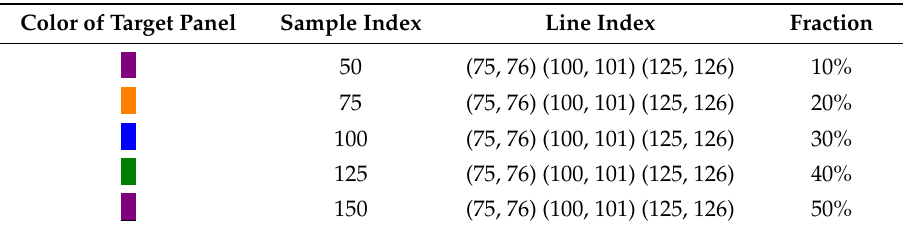
Figure 2. AVIRIS LCVF dataset for the experiment. ( a ) Image scene; ( b ) Implanted target locations in the image; ( c ) Implanted pure target spectrum and some representative background samples spectra; ( d ) Locations of the background samples given in ( c ). Table 1. Details of the implanted target panels for the AVIRIS LCVF dataset.